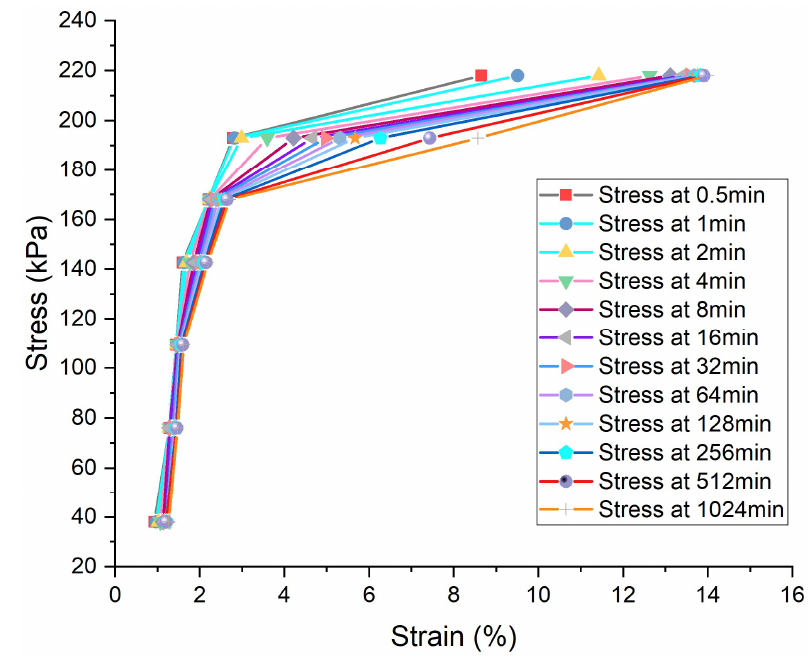
Figure 17. Isochronous ( σ 1 − σ 3 ) - ( ε 1 ) curves of Specimen No. 11, 4